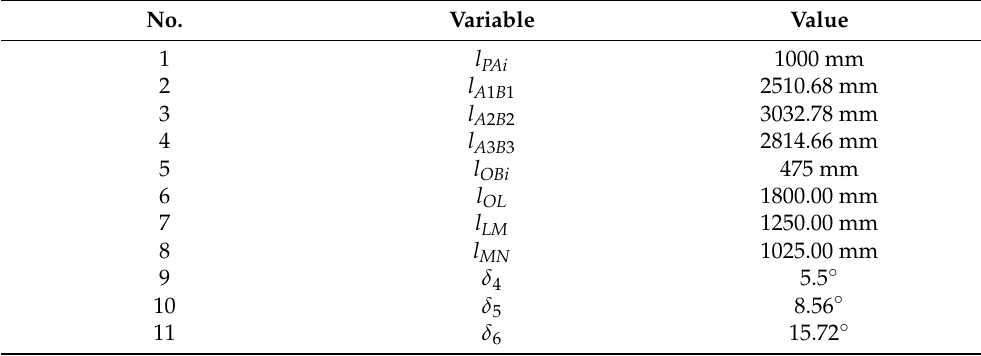
Figure 2. HKM structural features ( a ); HKM parallel mechanism coordinate system ( b ); HKM series mechanism coordinate system ( c ). Table 1. The structure design parameters of the HKM.